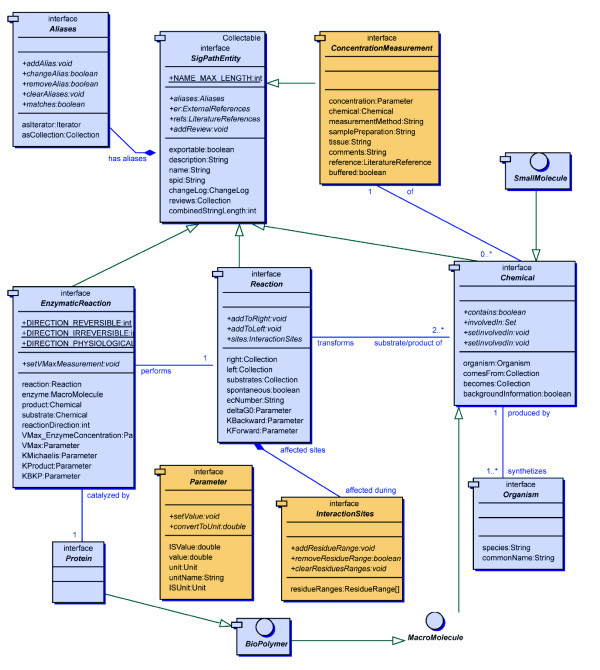
Fragment of the UML diagram for the SigPath ontology/database schema. The Figure shows how instances of certain classes are related and how the relationships among classes can be used to represent information. The link between Reaction and Chemical expresses the information that reactions transforms chemicals, and that chemical can be substrate or products of reactions. The classes and attribute marked in orange are specific to the SigPath ontology and have no equivalent in the EcoCyc ontology.